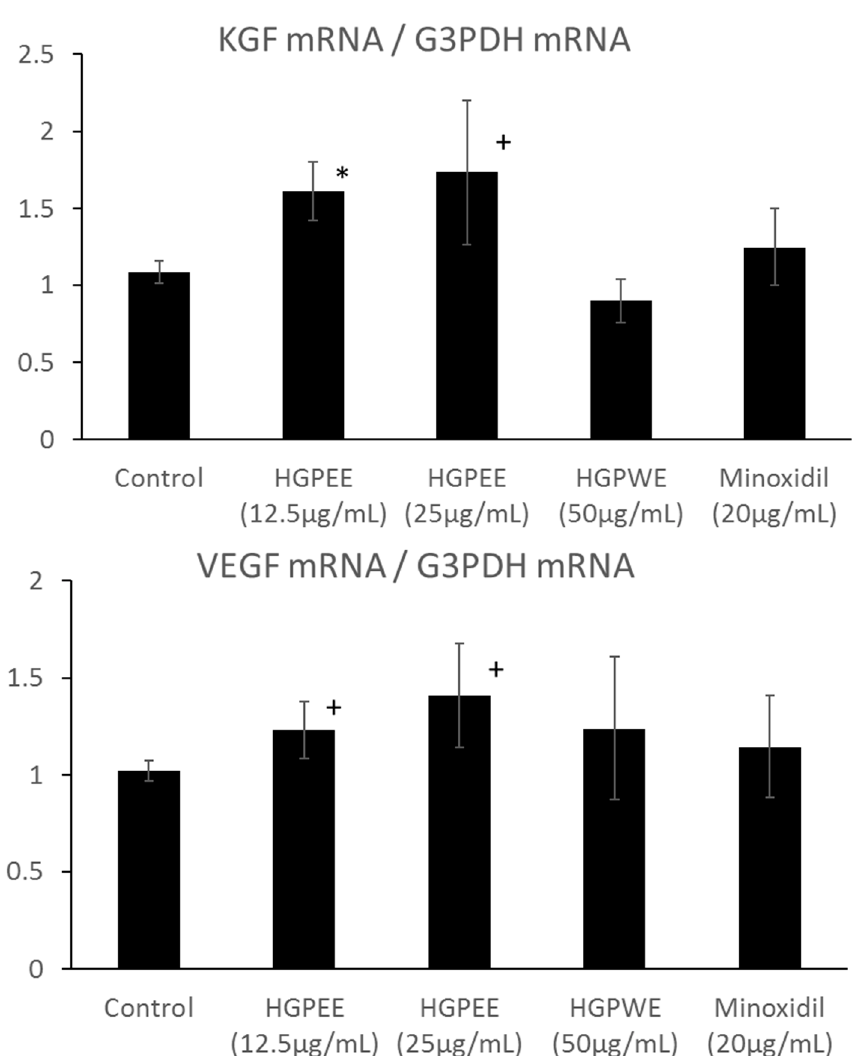
Figure 5. Effect of HGPEE, HGPWE, and minoxidil on the mRNA expressions of KGF, and VEGF in cultured human hair papilla cells. n = 3, mean ± S.D., * p < 0.05 vs. Control, + p < 0.1 vs. Control.